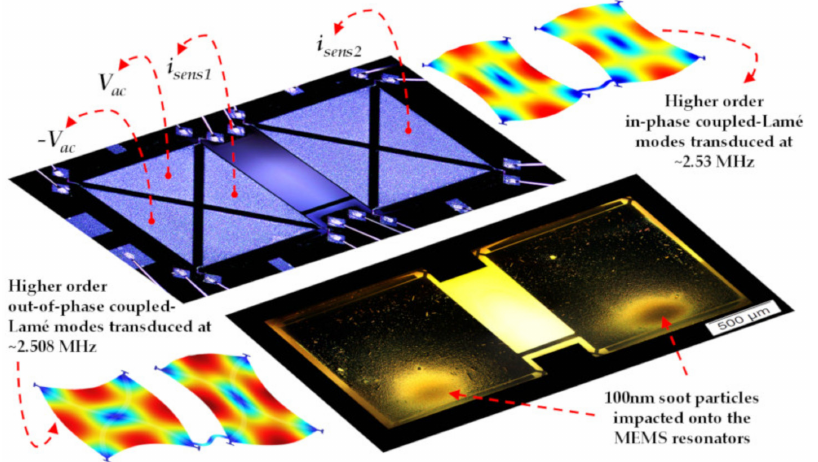
Figure 22. Schematic of the piezoelectric transduction mechanism applied to a 2-DoF weakly coupled BAW square-plate resonator device vibrating at in-phase and out-of-phase WG modes. The mass perturbation is conducted by applying particles onto the bottom surface of the resonators. Reprinted with permission from Ref.